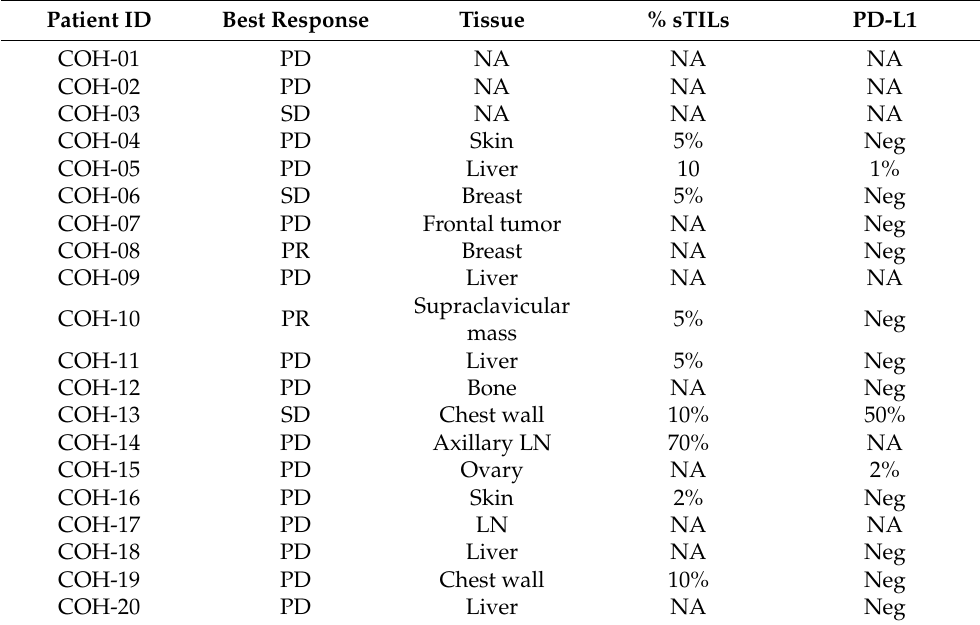
Table 4. Tumor Immune Biomarker sTILs and PD-L1 with 22C3 antibody (N =